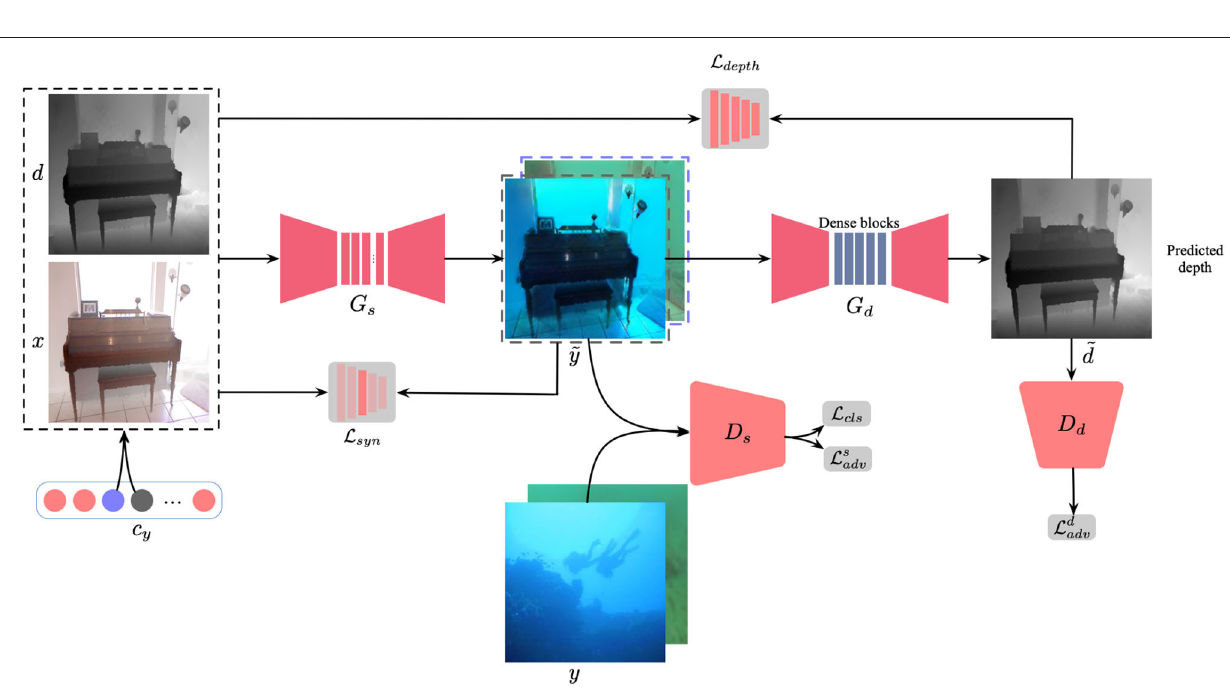
labels as input and transfers them to the original domain.